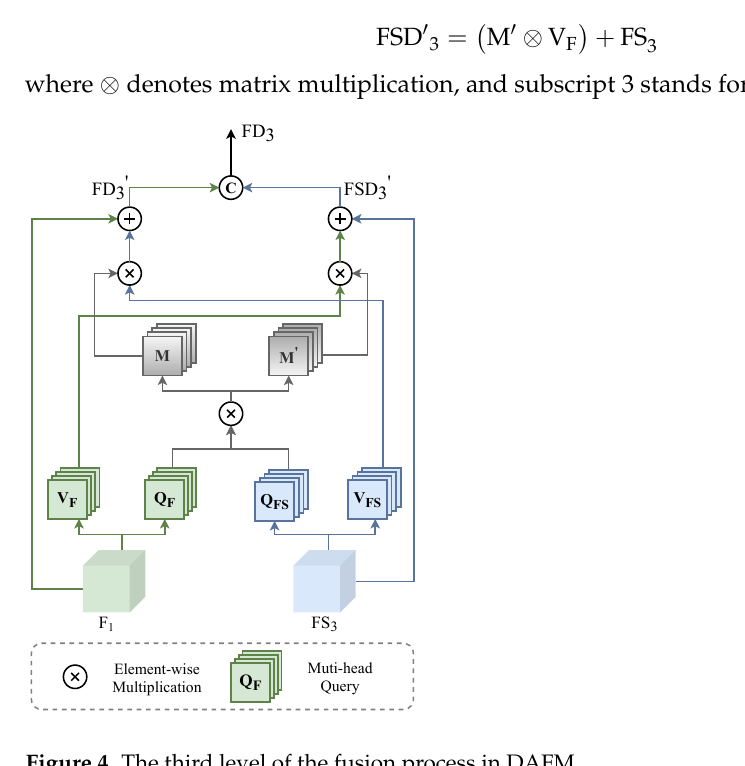
Figure 4. The third level of the fusion process in